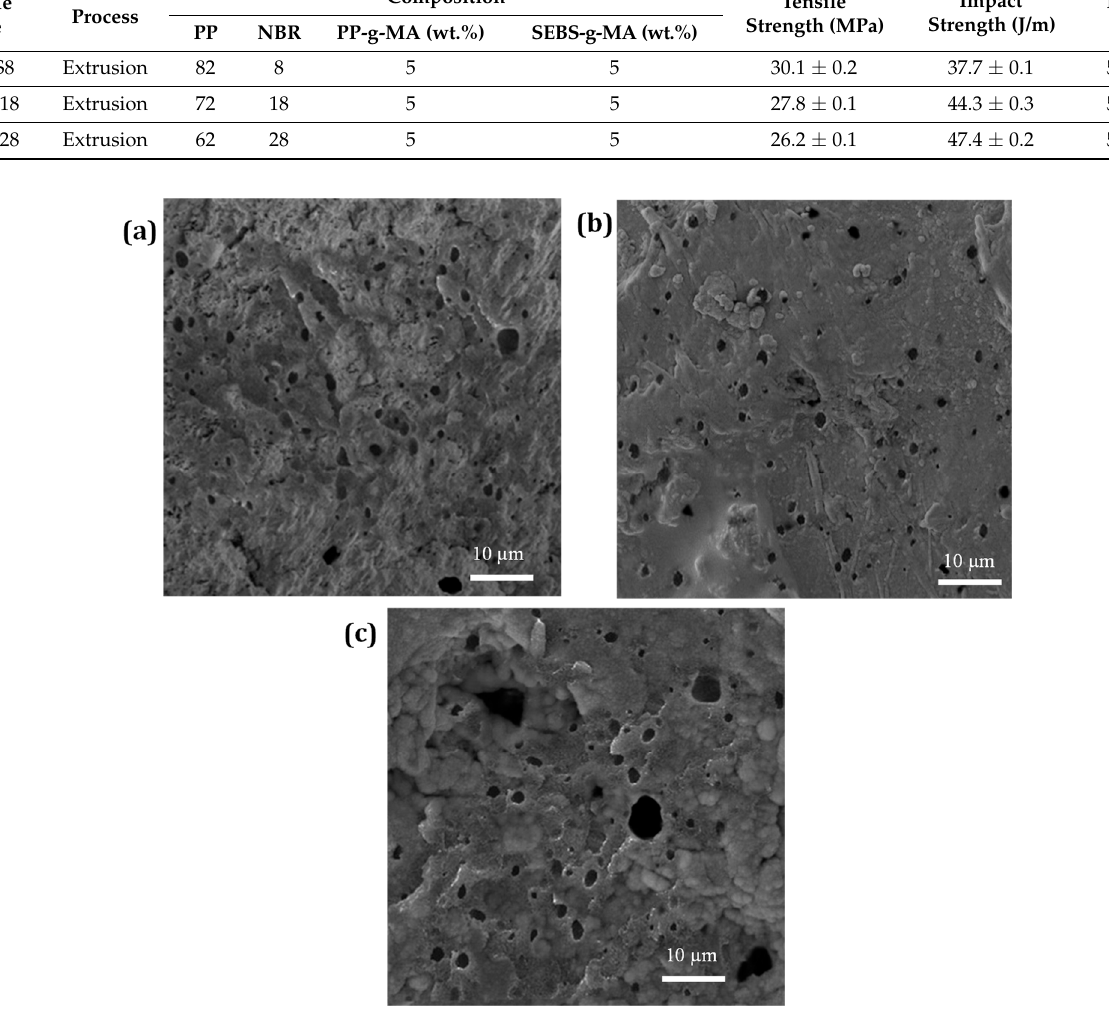
Figure 2. SEM micrographs of etched PP/NBR blends with ( a ) 10 wt.% NBR ( b ) 20 wt.% NBR ( c ) 30 wt.% NBR.